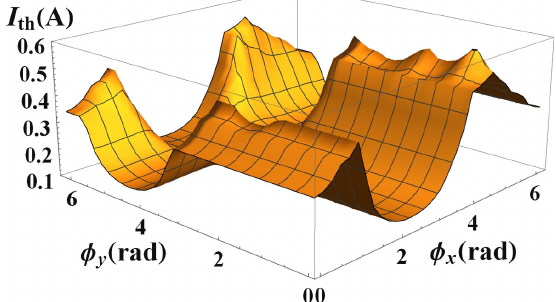
FIG. 10. A scan of BBU I over the two phase advances for the th CBETA 1-pass lattice. Each cavity is assigned with a random set of 3 dipole HOMs in both x and y polarization. ( ϵ ¼ 125 μ m). For this particular HOM assignment, I ranges from 140 mA to th 610 mA.